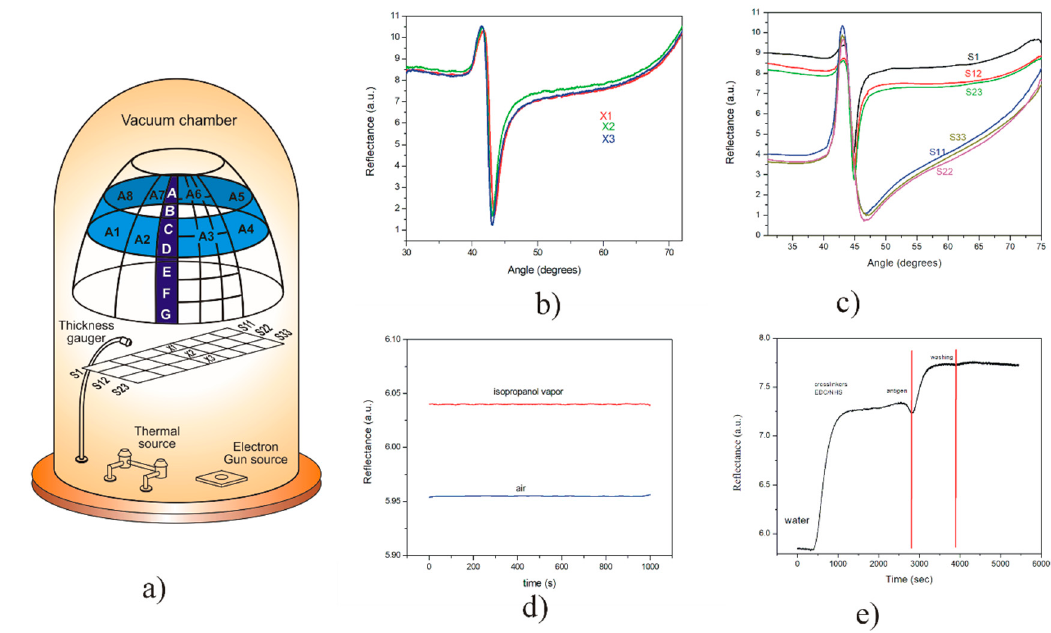
Figure 3. ( a ) Schematic representation of the location of substrates during deposition of Cr / Au with a rotation system (the upper cone) and without rotation (close to the thickness gauger in a vacuum chamber); ( b ) SPR curves of substrates X1, X2 and X3 that correspond to the central position of coated substrates without rotation (quartz monitor close to position X1), ( c ) SPR curves of the three substrates of the extreme left and extreme right in the system; ( d ) SPR measurement of the presence of isopropyl alcohol vapours in comparison with air, using a Cr / Au substrate of thickness 28 / 300 Å, based on measurements of intensity changes by SPR at a fixed angle; ( e ) SPR signal of the biofunctionalization of Cr / Au thin film corresponding to substrate X1, employing the EDC / NHS method for polyclonal antibody (50 µ g mL − 1) immobilization for an antigen-antibody recognition.